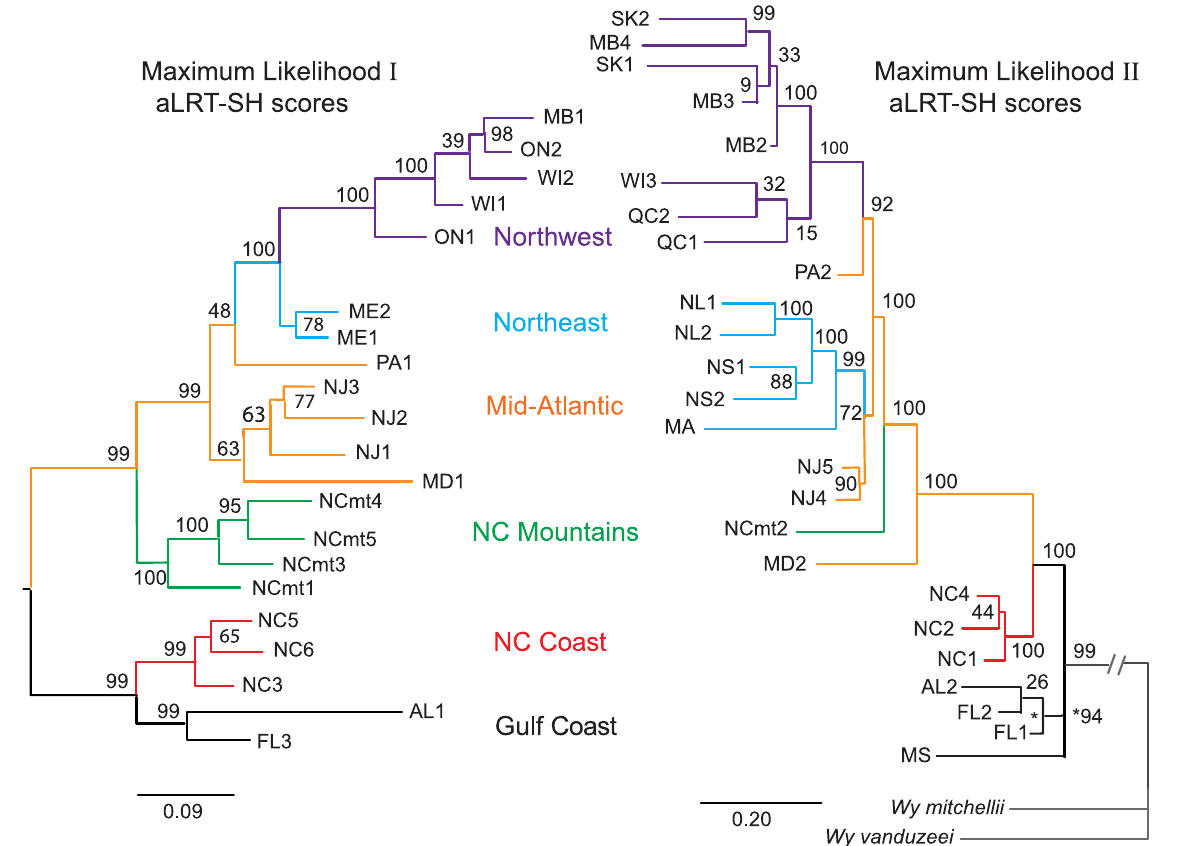
Figure 1. Replicability of maximum likelihood trees. Left , phylogenetic tree from [1] using 21 populations and 54 bp reads Right , phylogenetic tree from the current study using 25 populations and 80 bp reads. Branches leading to W. mitchellii and W. vanduzeei are abbreviated to clarify presentation. Color code indicates region of geographic origin. Numbers show nodal support as aLRT-SH scores. Two-letter abbreviations identify each state or province. Where two or more sites come from the same state or province, they are identified by number. Latitudes, longitudes, altitudes, and acronyms connecting the specific localities with earlier studies from this lab are provided in Table S1. The scale bars indicate substitutions per site.